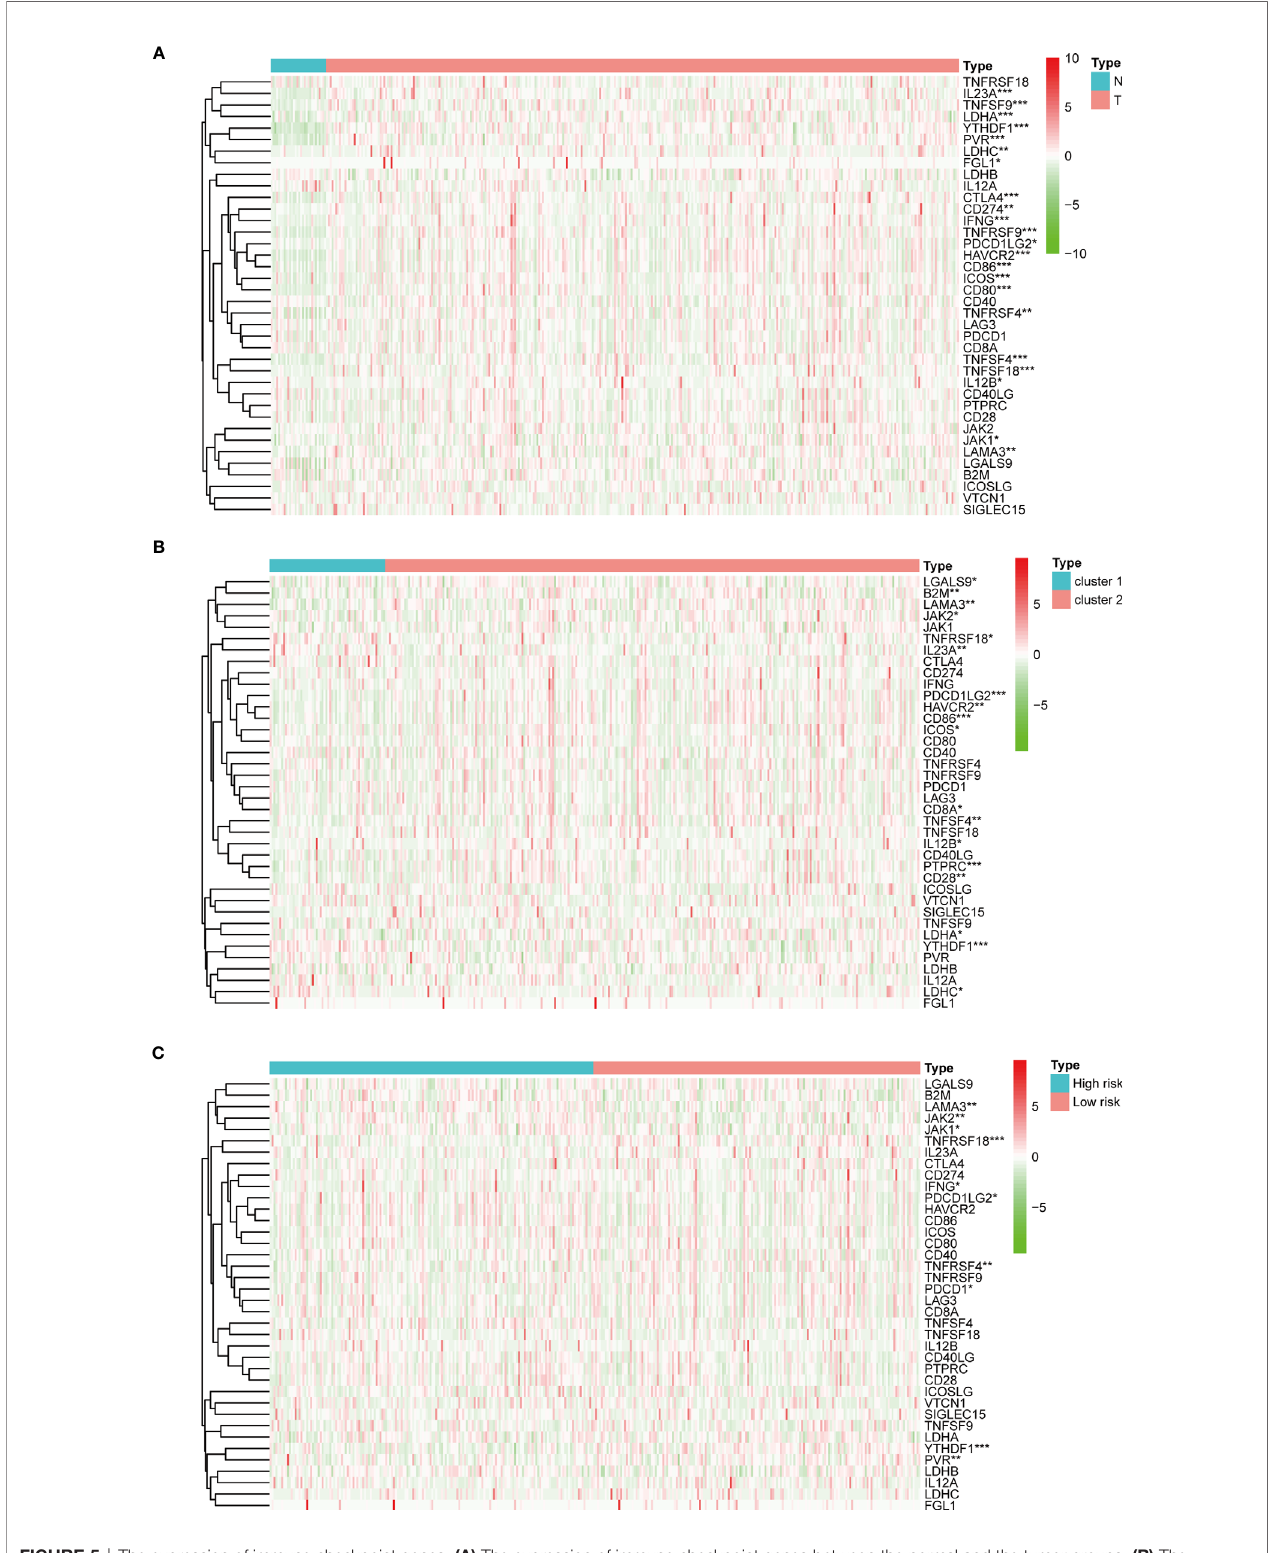
FIGURE 5 | The expression of immune checkpoint genes. (A) The expression of immune checkpoint genes between the normal and the tumor groups. (B) The expression of immune checkpoint genes between cluster I and cluster II. (C) The expression of immune checkpoint genes between the high-risk and the low-risk groups. * p < 0.05, ** p < 0.01, and *** p <